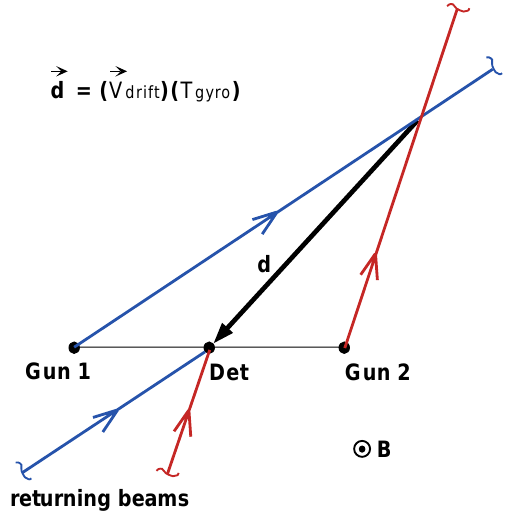
Fig. 1. Principle of EDI triangulation, projected in the plane perpen- dicular to B . The gyro radius of the beam electrons is much larger than the scale of the figure, so the beams appear as straight lines. The “drift step”, d , is the gyro motion displacement in exactly one gyro period. With the head of the d vector placed at the detector, electron beams successfully aimed at the tail of d will return to the detector after one gyro orbit. The combined firing directions of two guns and the known geometric positions of the guns and detector are sufficient to determine the drift step, and thus the drift velocity, from